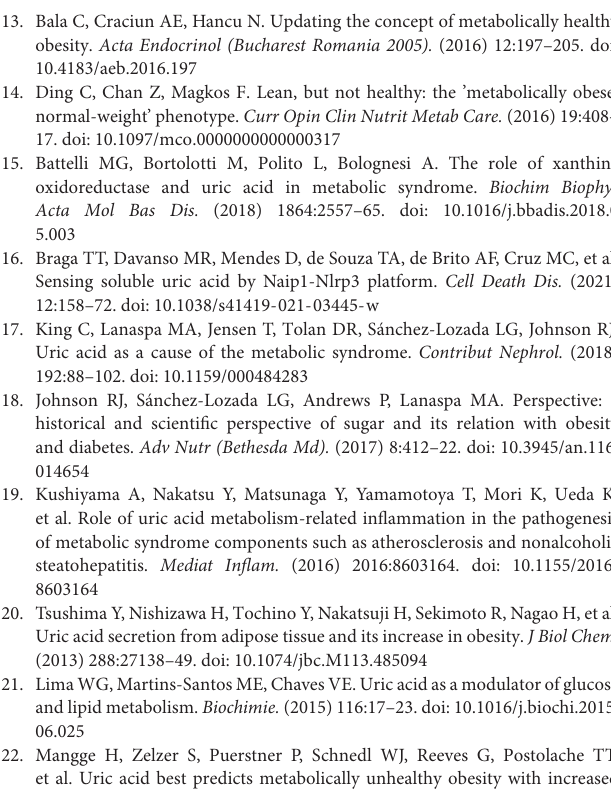
Supplementary Figure 1 | Flow chart of the study